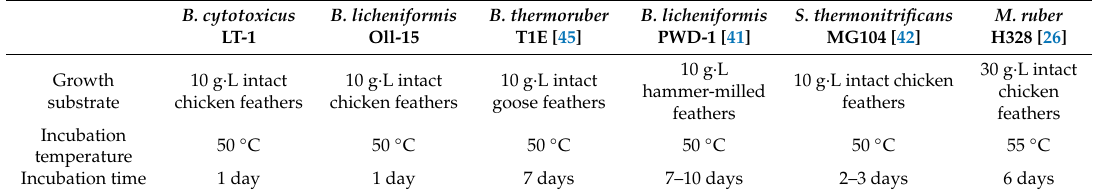
Table 2. Comparison of feathers degradation by aerobic, thermophilic